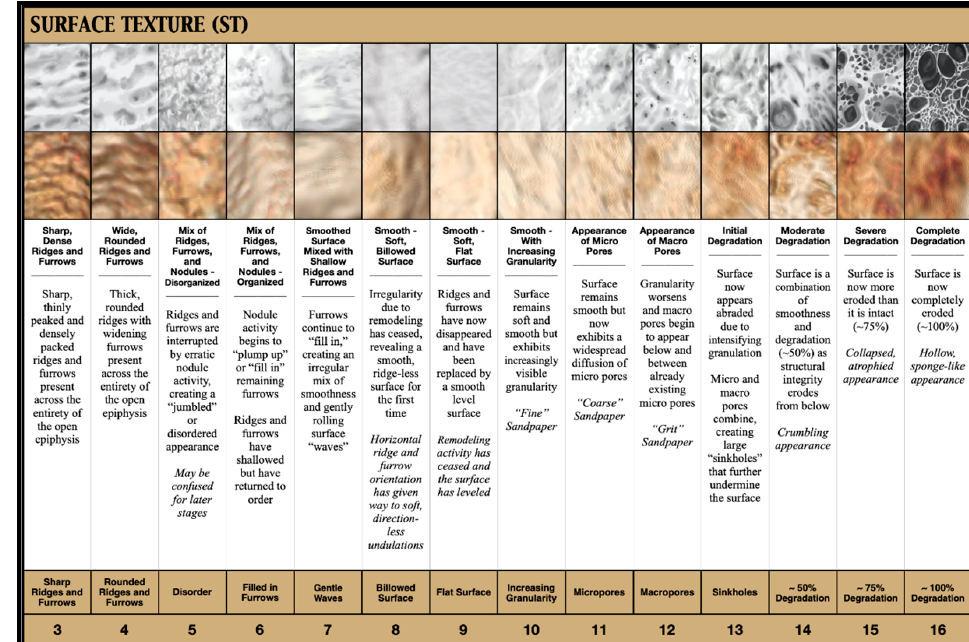
Figure 8. Surface Texture .